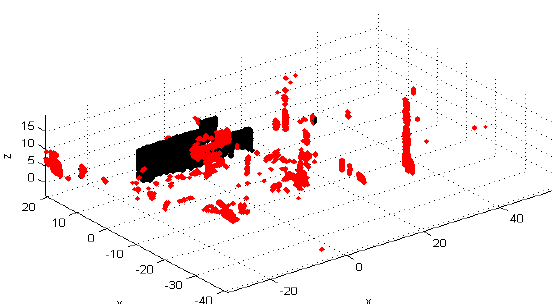
Figure 3. Point cloud filtered by RANSAC Paradigm. Black colored points are those recognized as facade points and red colored points can be